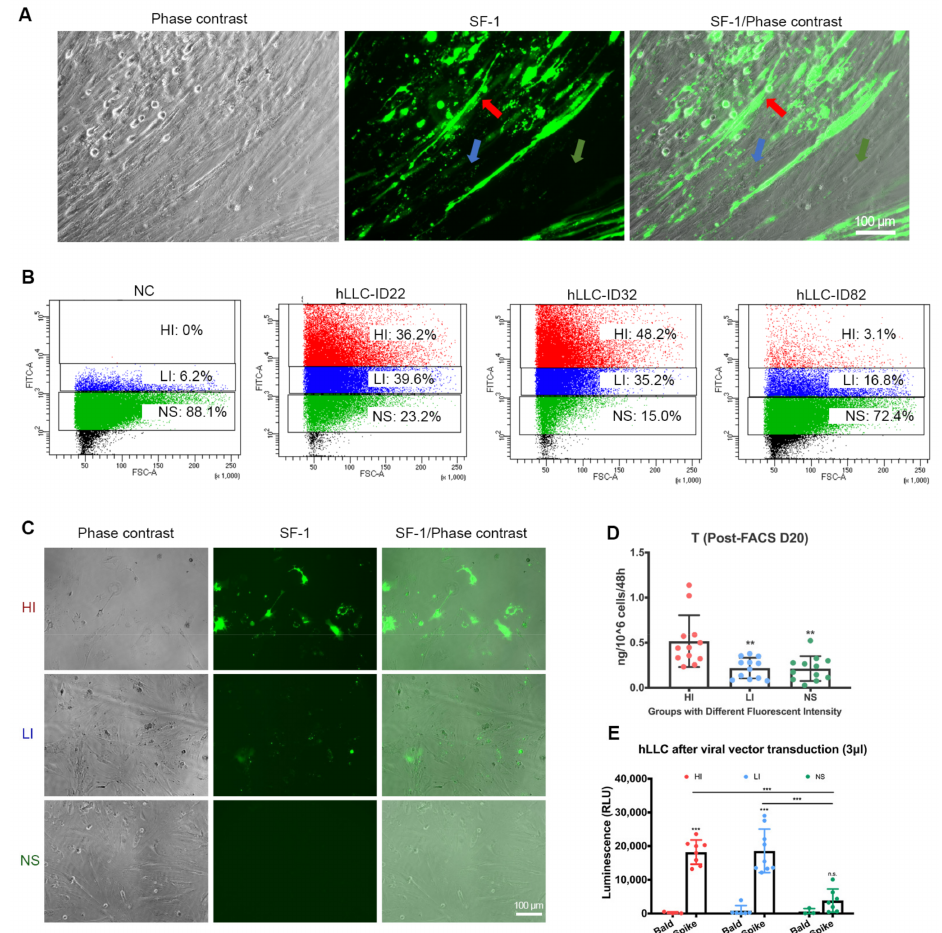
Figure 5. SARS-CoV-2 spike pseudovectors enter hLLCs rather than other induced cells. ( A ) Induced hLLCs are a mixture of cells presenting different ZsGreen1 intensities (green signals). The red, blue, and green arrows point to hLLCs with intense, low or scattered, and negligible ZsGreen1 signals, respectively. ( B , C ) The fluorescence-activated cell sorting (FACS) analysis classified mixed hLLCs into high-intensity (HI), low-intensity (LI), and no signal (NS) groups. Early mesenchymal progenitors (EMPs) cultured in hLLC induction medium without DOX were used as the negative control (NC). The hLLCs at induction day (ID) 22, 32, and 82 were used for the FACS analysis. ( C ) After FACS, hLLCs with different ZsGreen1 intensities were cultured in the hLLC induction system and observed under a fluorescent microscope. ( D ) The HI group produced significantly higher levels of T than the LI and NS groups. ( E ) SARS-CoV-2 spike pseudovector can only enter HI and LI groups but not the NS group. Data are presented as means ± SDs, n ≥ 3. Not significant = n.s. at p > 0.05; ** p < 0.01; *** p <